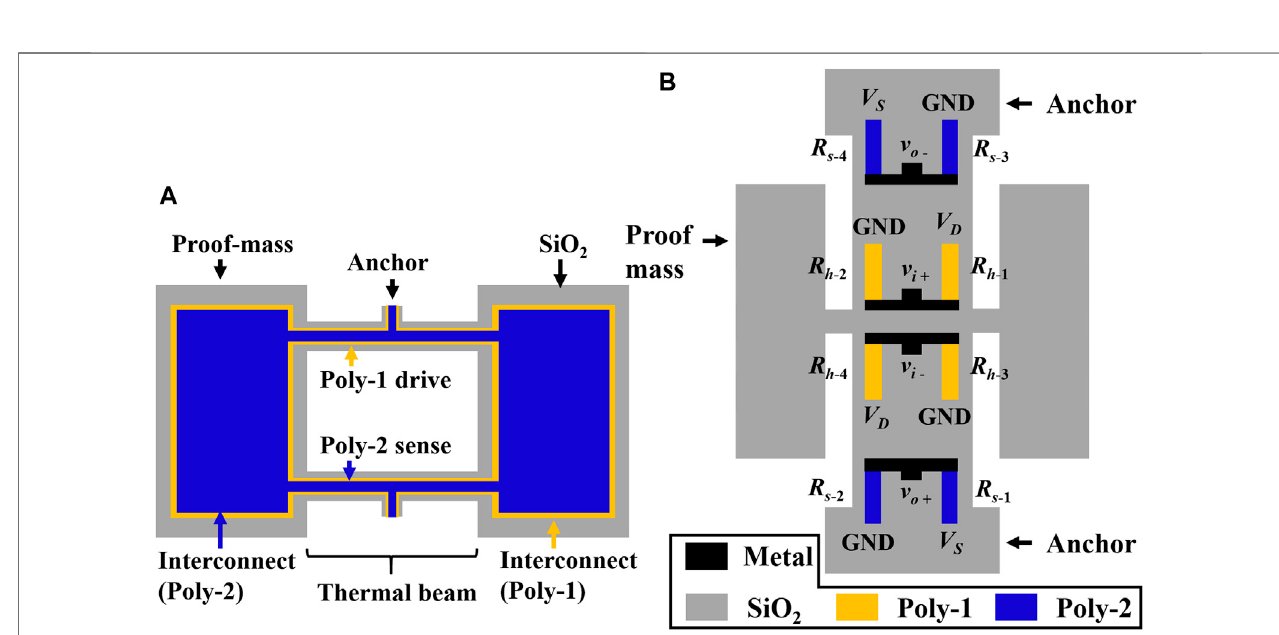
FIGURE 3 | Simpli fi ed schematic representation of (A) II-bar and (B) clamped-clamped beam (CCB).